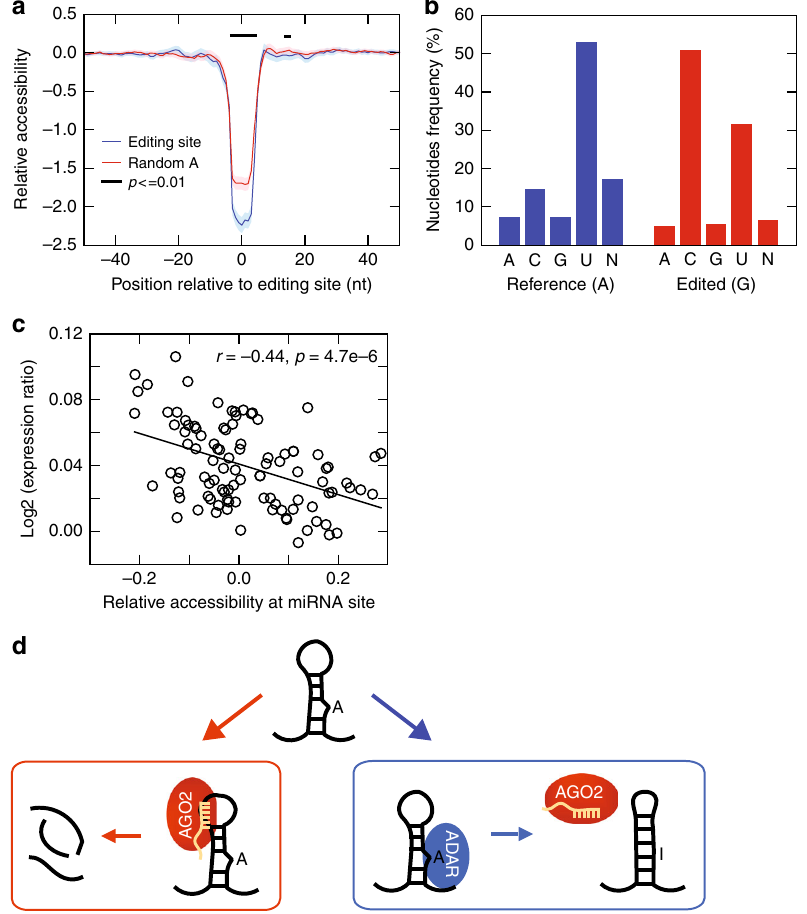
Fig. 6 Editing-dependent RNA structural changes near AGO2-miRNA target sites. a Pro fi le of relative 7mer accessibility around editing sites located in 3 ′ UTRs and within 100 nt from predicted miRNA target sites (blue), and around random A positions (red). Y -axis shows log2 fold change in the probability of accessibility of a 7mer (centered at the position indicated on the x -axis) between structures folded using the edited (G) vs. unedited (A) version of the sequences calculated using RNAplfold 46 (see Methods). Shaded areas represent con fi dence intervals. Black bar indicates regions with a signi fi cant difference comparing the relative accessibilities around editing sites and random A ’ s ( p value < 0.01, Wilcoxon Rank-Sum test). b Nucleotide frequencies opposite to the editing site in minimum free energy structures predicted with RNAfold 68 using the unedited (blue bars) and edited sequences (red bars). ‘ N ’ is shown for structures where the editing site was unpaired and the opposite nucleotide was ambiguous (e.g., if the editing site was in a hairpin loop or bulge with multiple likely opposite nucleotides). c Correlation between relative 7mer accessibilities (calculated as in a ) at predicted miRNA target sites ( x -axis) and gene expression differences between edited (editing level ≥ 0.3) and non-edited individuals ( y -axis, ratio calculated as edited/non-edited). Each circle represents average values of relative accessibility and expression ratio of a group of miRNA target sites ( x -axis) and genes ( y -axis) with similar distance (differing by ≤ 10 nt) between editing sites and miRNA target sites. Pearson correlation coef fi cient and signi fi cance of correlation are shown. d Scheme for the proposed structure-mediated regulation of target mRNA abundance depending on A-to-I